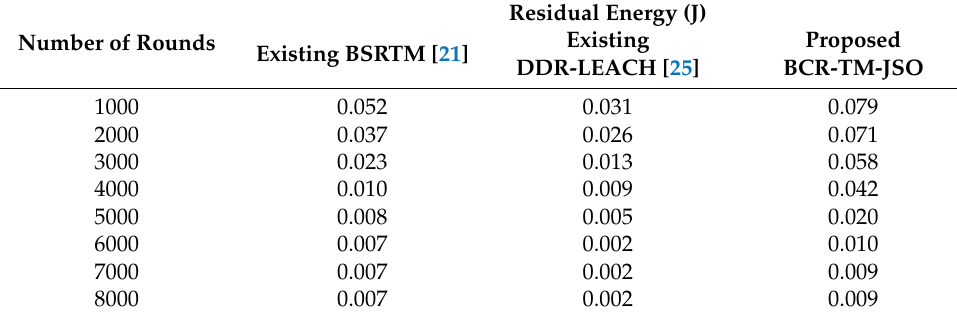
Table 9. Performances of residual